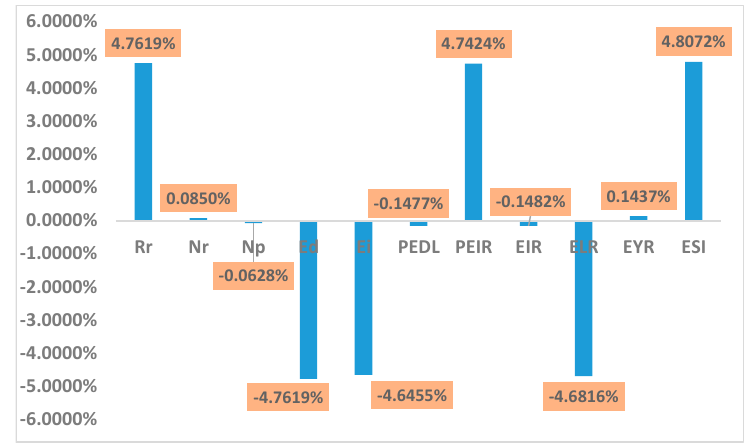
Figure 5. The indicator changes between former and latter.